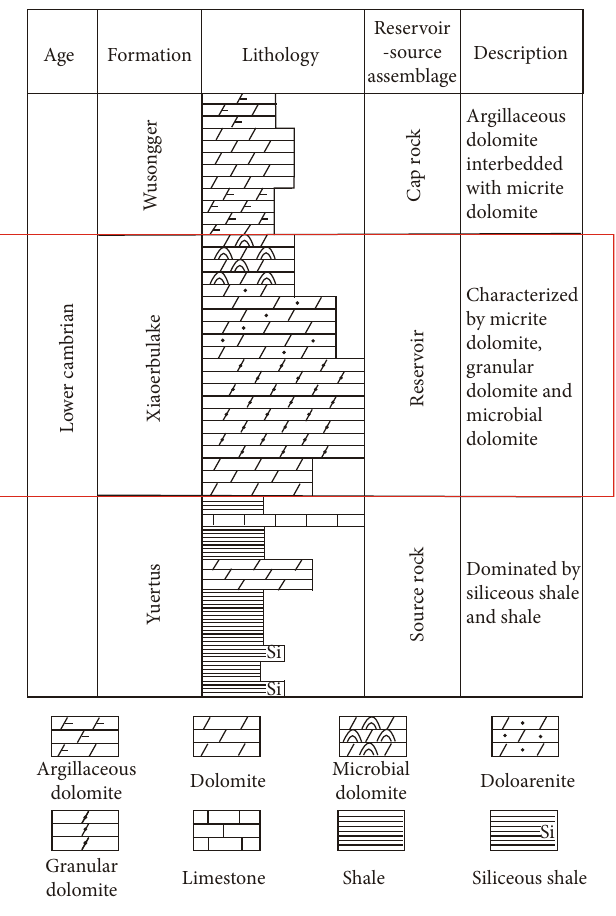
Figure 2: Stratigraphic column of the Lower Cambrian in the Keping area (modi fi ed after Wang et al. [22] and Jiang et al.